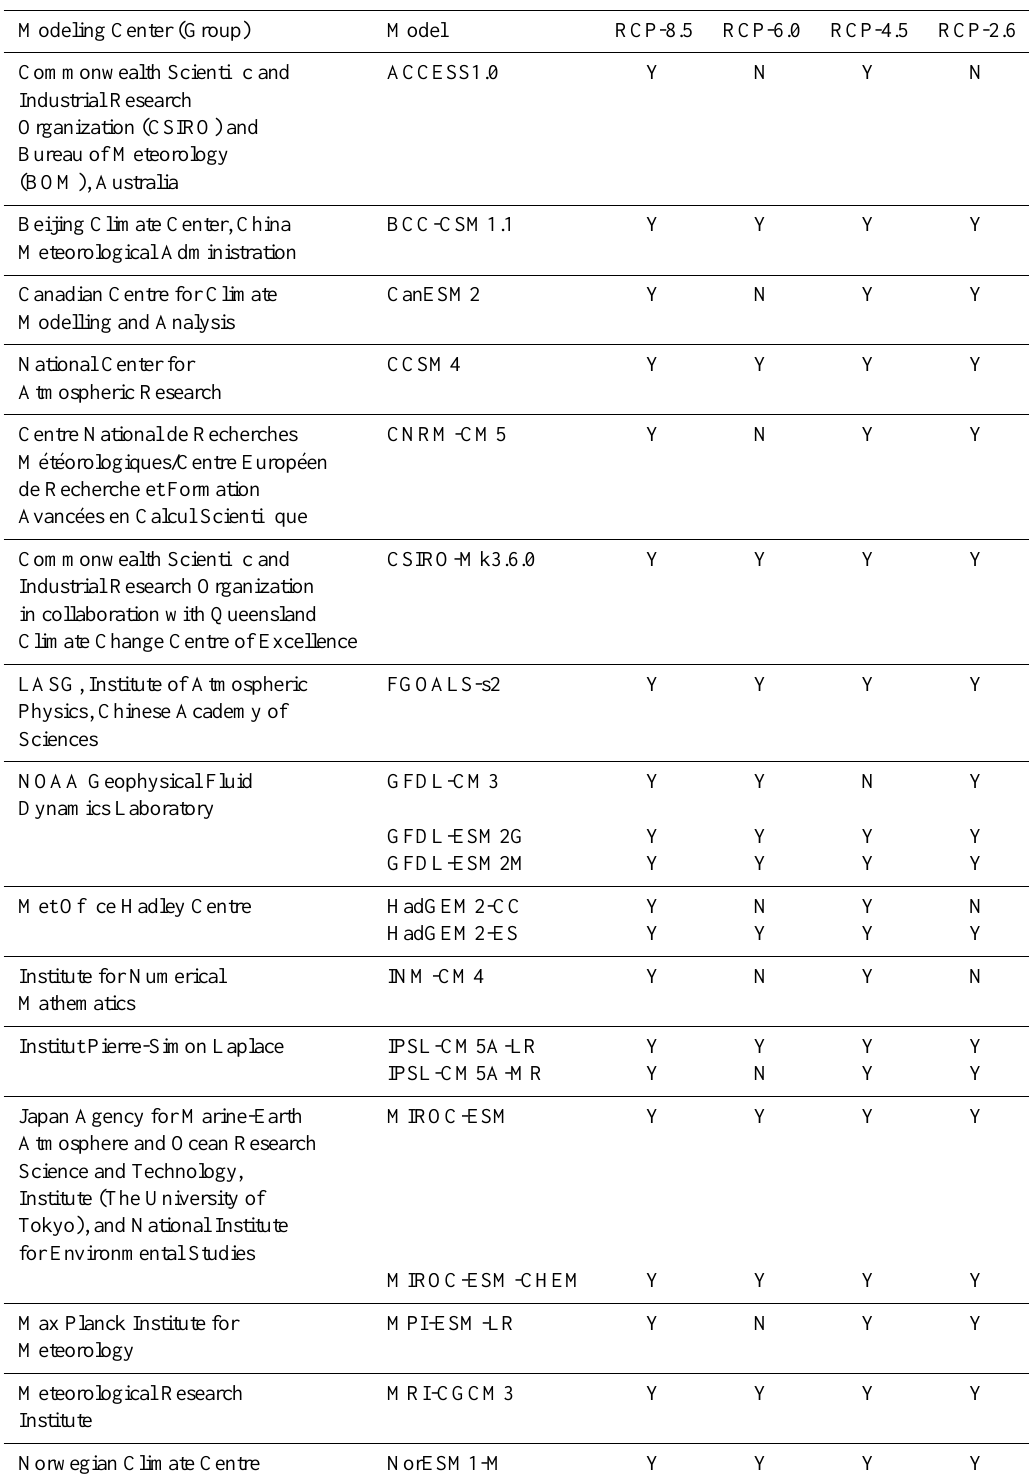
Table 1. Details of the data availability for the 20 comprehensive models used in the study. Only those models are selected for which data for historic period, RCP-8.5 and at least one more scenario are available at the time of the